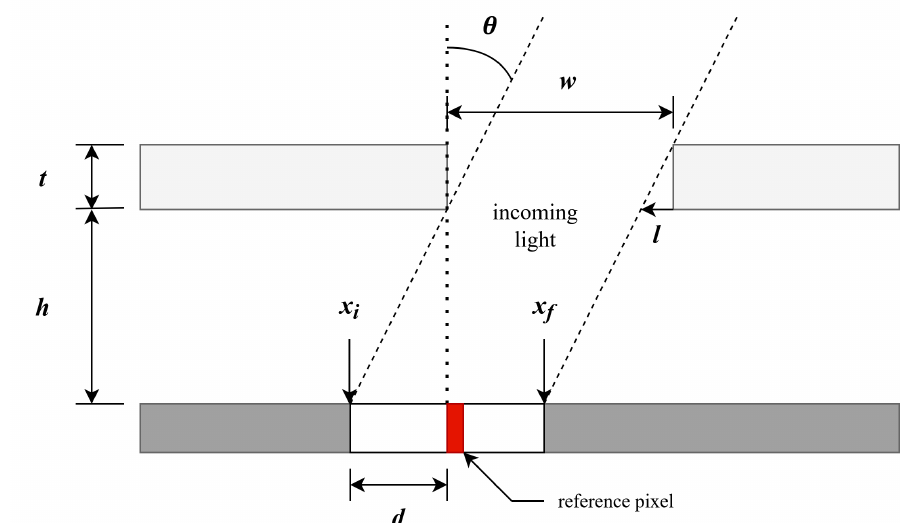
Figure 2. Digital sun sensor readout geometry with single-slit mask. A reference pixel (highlighted in red) is defined as the pixel directly under the mask slit.